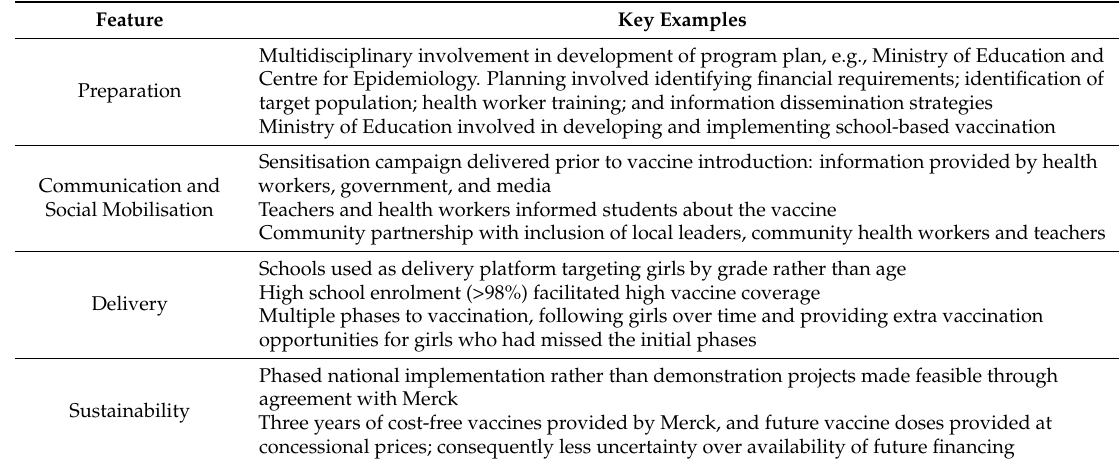
Table 3. Key Features Contributing to the Success of Rwanda’s HPV Vaccination Program [7,23,26]. Feature Key